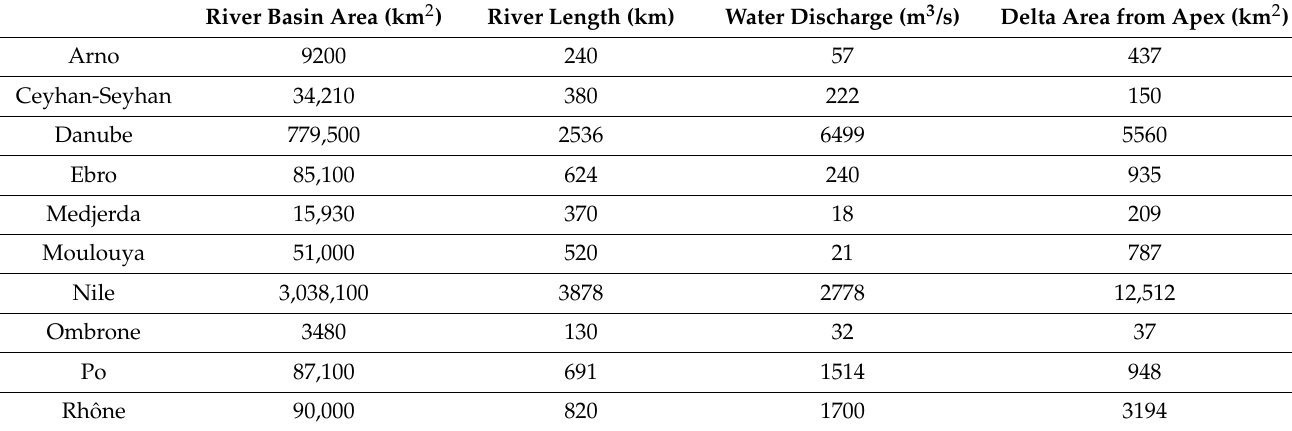
Table 1. Selection of data on the ten deltas and on their catchments and river discharge, adapted from data culled by [8]. River Basin Area (km 2 ) River Length (km) Water Discharge (m 3 /s) Delta Area from Apex (km 2 )